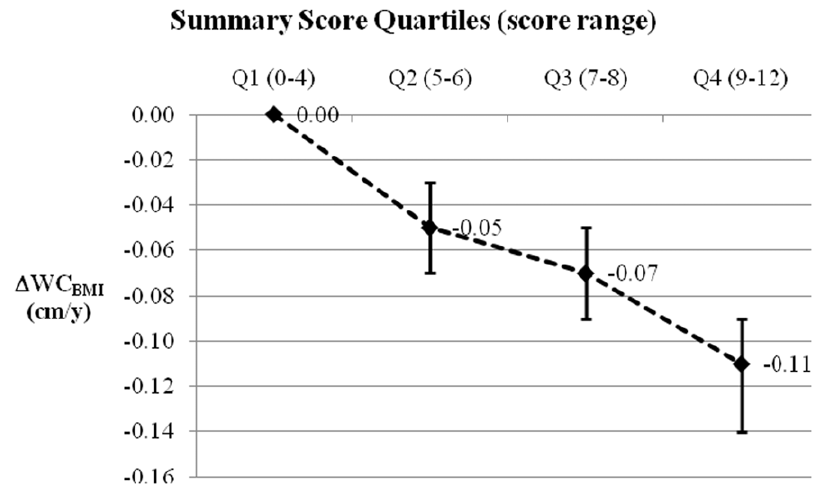
Figure 1. Estimated global association between a summary score reflecting a dietary pattern with a high content of fruit and dairy products, and low content of white bread, processed meat, margarine, and soft drinks and annual change in ‘‘waist circumference for a given body mass index ( D WC BMI , cm/y)’’. The association between the quartiles of the summary score (quartile 1 or Q1 is the reference category) and D WC BMI was modelled using centre-specific linear regression [adjusting for: total energy intake, age, baseline weight, baseline height, baseline WC BMI , smoking, alcohol intake, physical activity, education, follow-up duration, menopausal status (women only), and hormone replacement therapy use (women only)], and random-effect meta-analyses to obtain pooled estimates of the